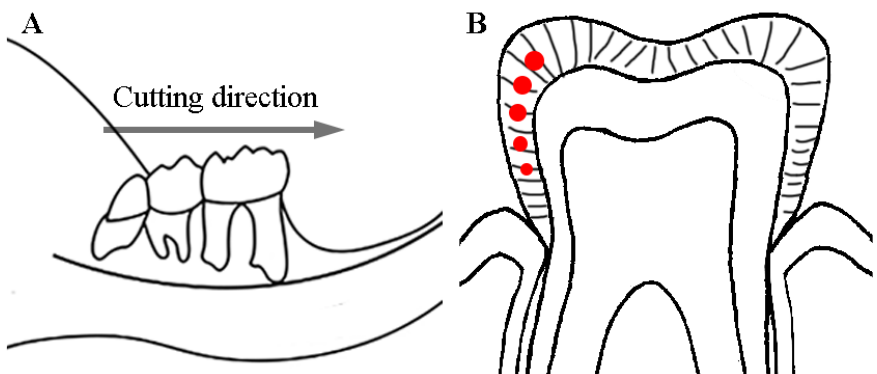
Figure 1. The sketch of the sample preparation method: ( A ) The cutting direction went along the mesial and distal direction of the teeth. ( B ) The sectional drawing shows the axial surface of the tooth; the red dots indicate that the detection area was in the middle layer of enamel in the M1 molars.